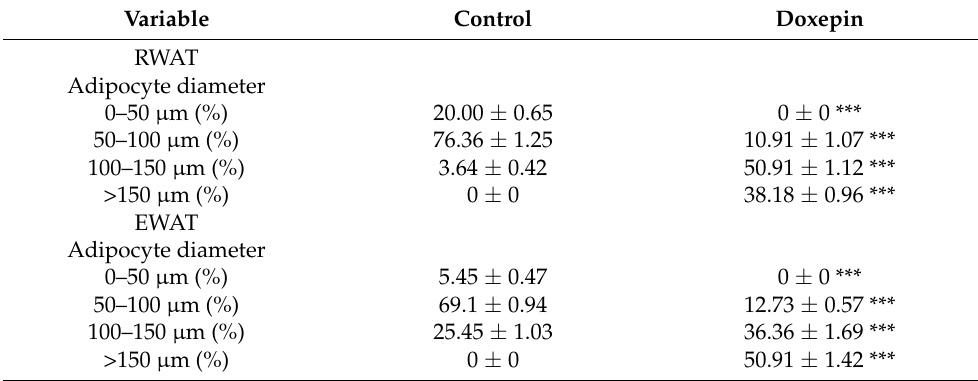
Figure 3. ( a ) H&E staining of livers, RWAT, and EWAT (magnification, 200 × ) and changes in ( b ) fatty liver score and the sizes of ( c ) RWAT and ( d ) EWAT adipocytes in control and doxepin-treated obese mice over 56 treatment days. All values denote the mean ± standard deviation ( n = 10 for all groups). *** p < 0.001 indicate very high statistical significance. Table 1. Adipocyte size distribution in control and doxepin-treated obese mice over 56 treatment